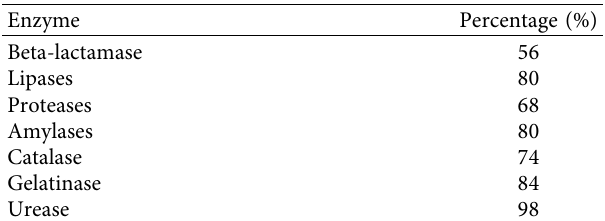
Table 6: Extracellular enzymatic activities in various species of P. vulgaris from the hospital